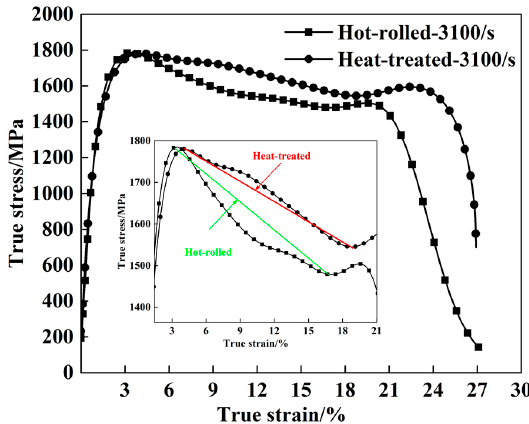
Figure 8. Dynamic true stress–strain curves of the hot-rolled and heat-treated titanium alloys tested at a strain rate of 3100/s. The inset image shows the descent rate after the yield point.